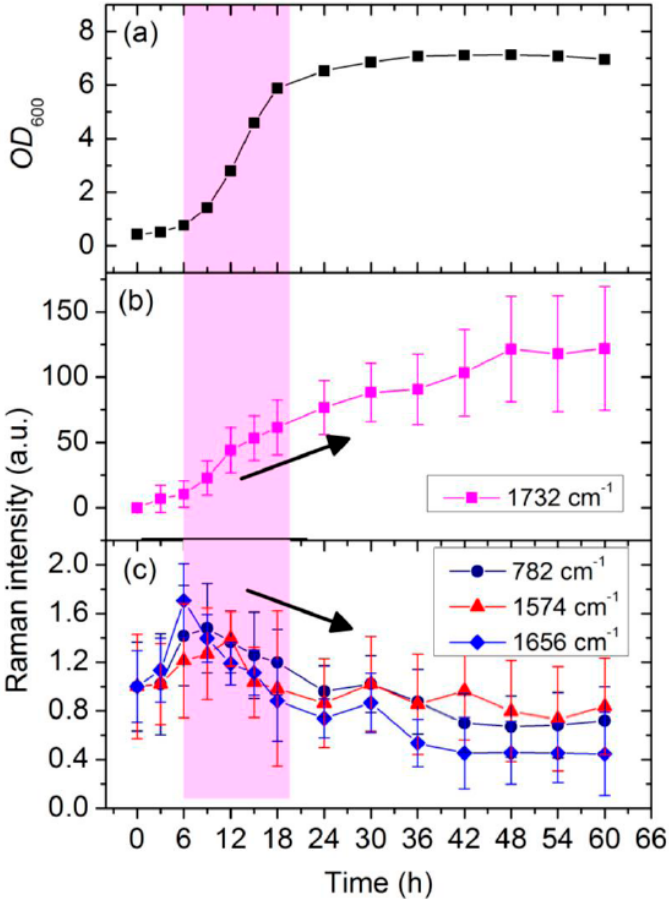
Figure 4. ( a ) Growth curve of a single culture of C. necator H16; ( b ) kinetic intensities of peaks at 1732 cm − 1 (PHB); and ( c ) kinetic intensities of peaks at 782 cm − 1 (RNA), 1574 cm − 1 (DNA), and 1656 cm − 1 (proteins), as functions of incubation time. The pink bar illustrates exponential phase of cell growth, and the error bar is standard deviation.